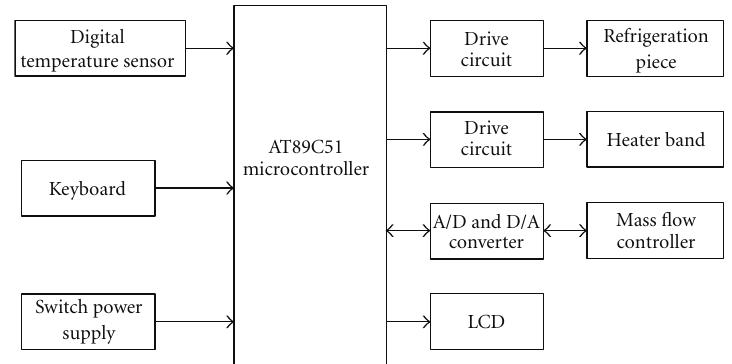
Figure 2: Electrical schematic diagram of GP-HS-LPME